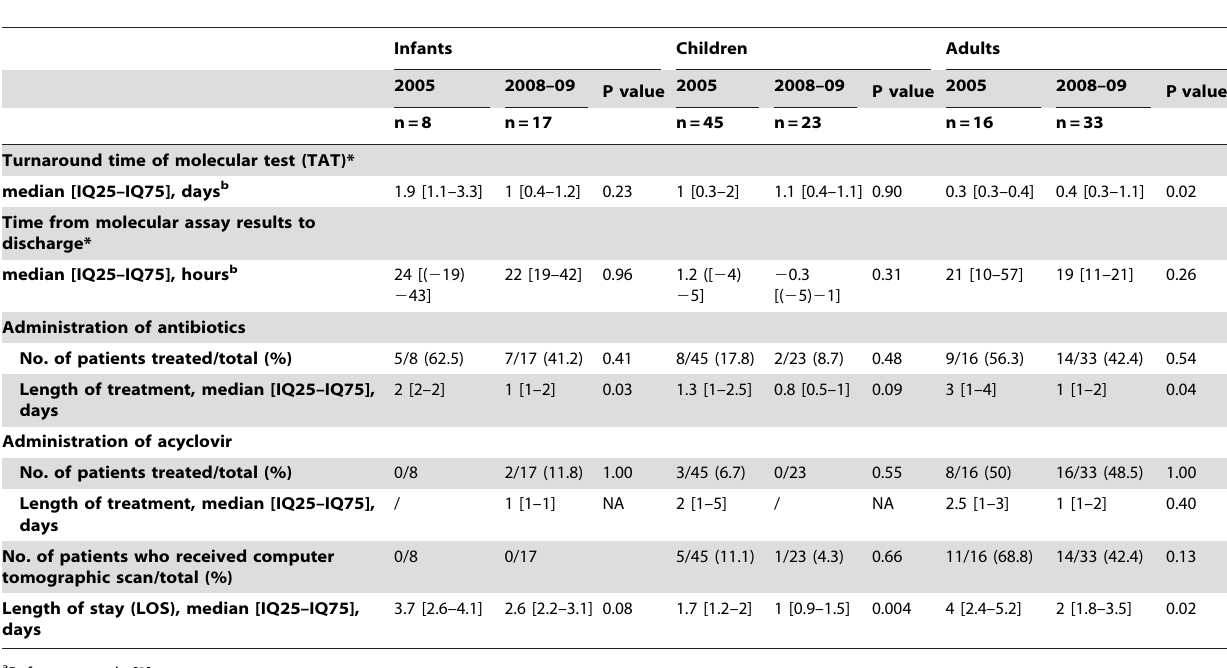
Table 1. Comparison of time parameters and service use in infants, children, and adults with enterovirus meningitis in 2008–09 with those of a previous observational study in 2005 a